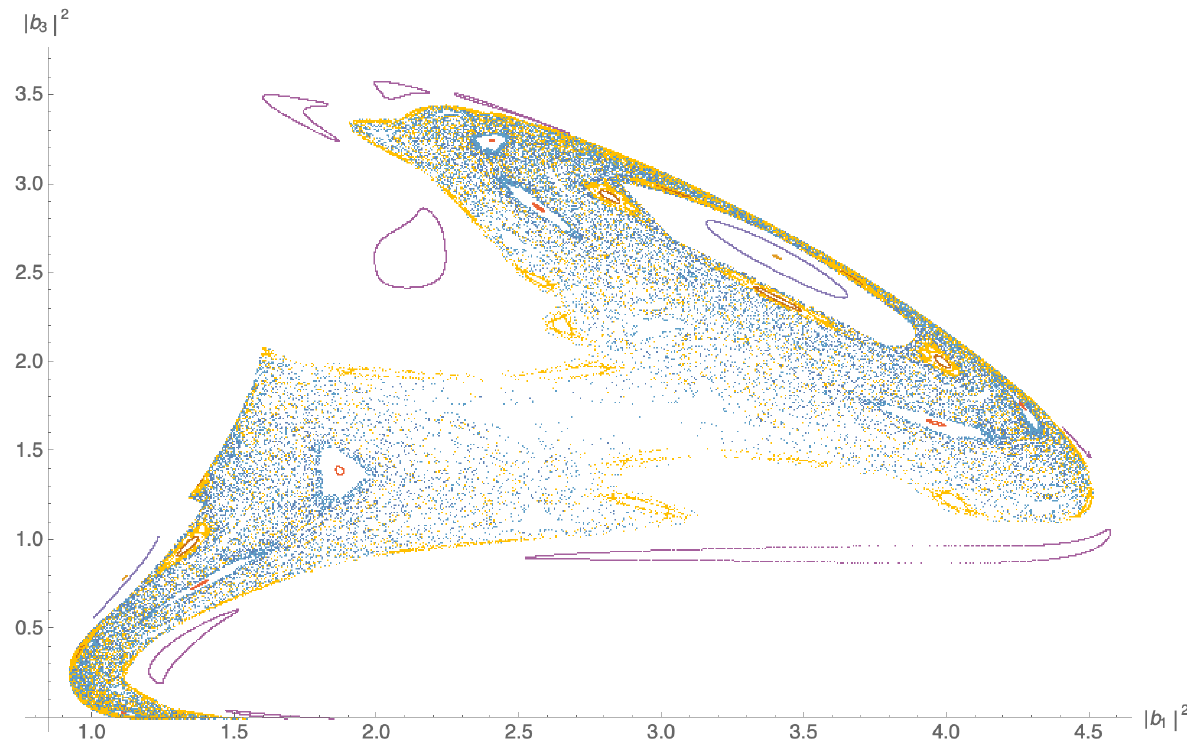
Figure 1. Poincaré cuts for the homogeneous version of the system consisting of two interacting quintets made out of three central modes and their negative